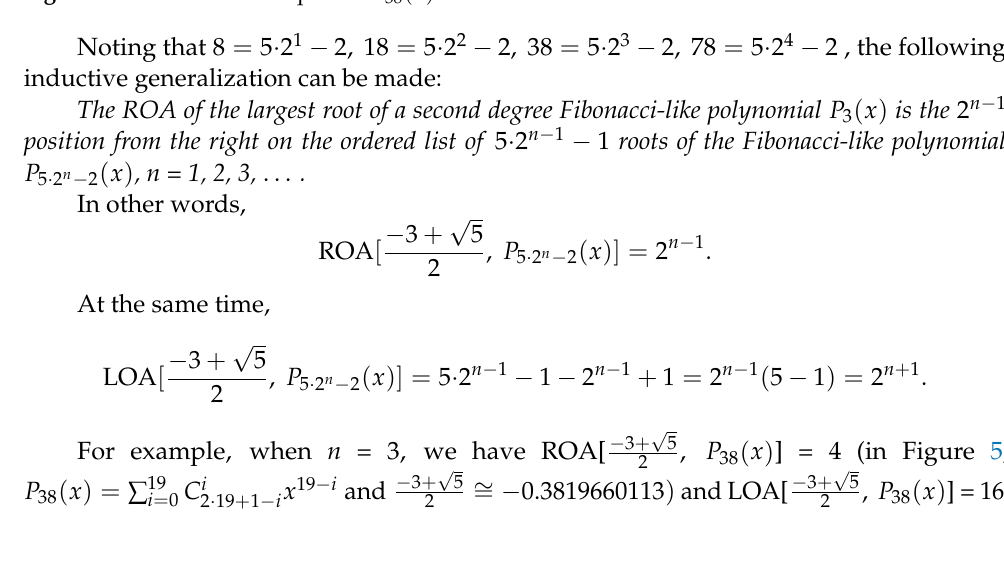
Figure 5. The roots of the equation 𝑃 38 (𝑥) = 0